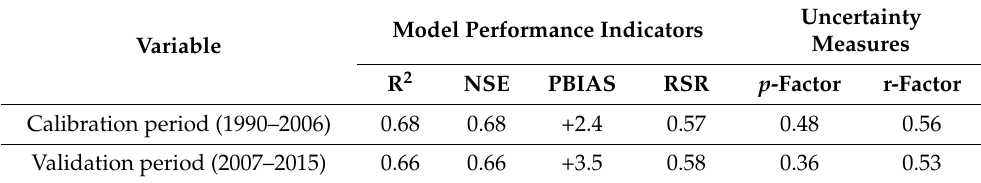
Table 8. The statistical properties index value for sediment flow calibration and validation processes and the uncertainty